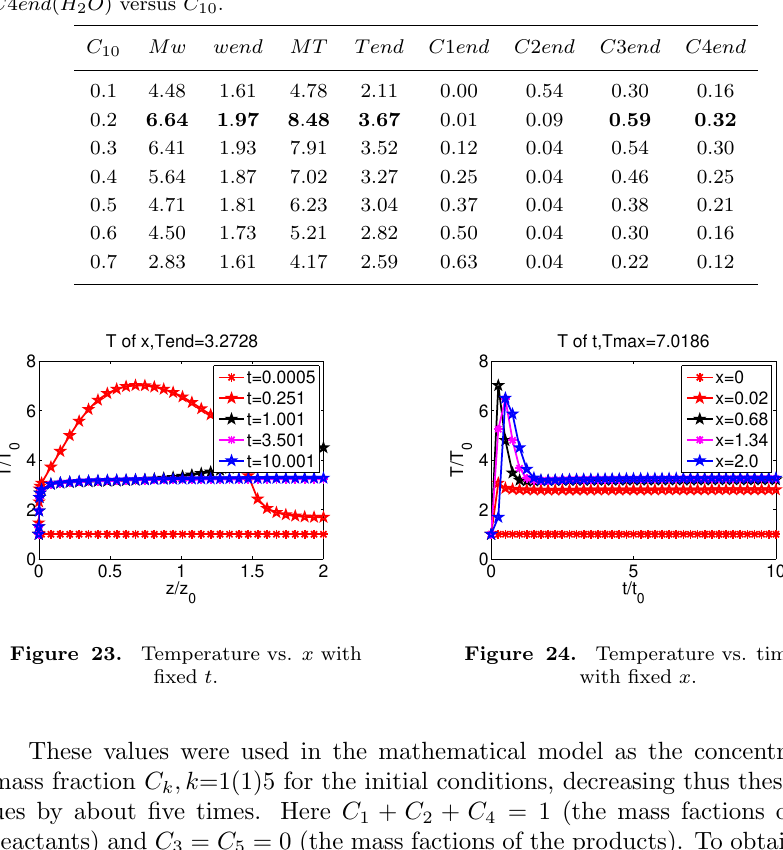
Table 3. Values of Mw,wend,MT,Tend,C 1 end ( C 3 H 8 ) ,C 2 end ( O 2 ) ,C 3 end ( CO 2 ), C 4 end ( H 2 O ) versus C 10 .